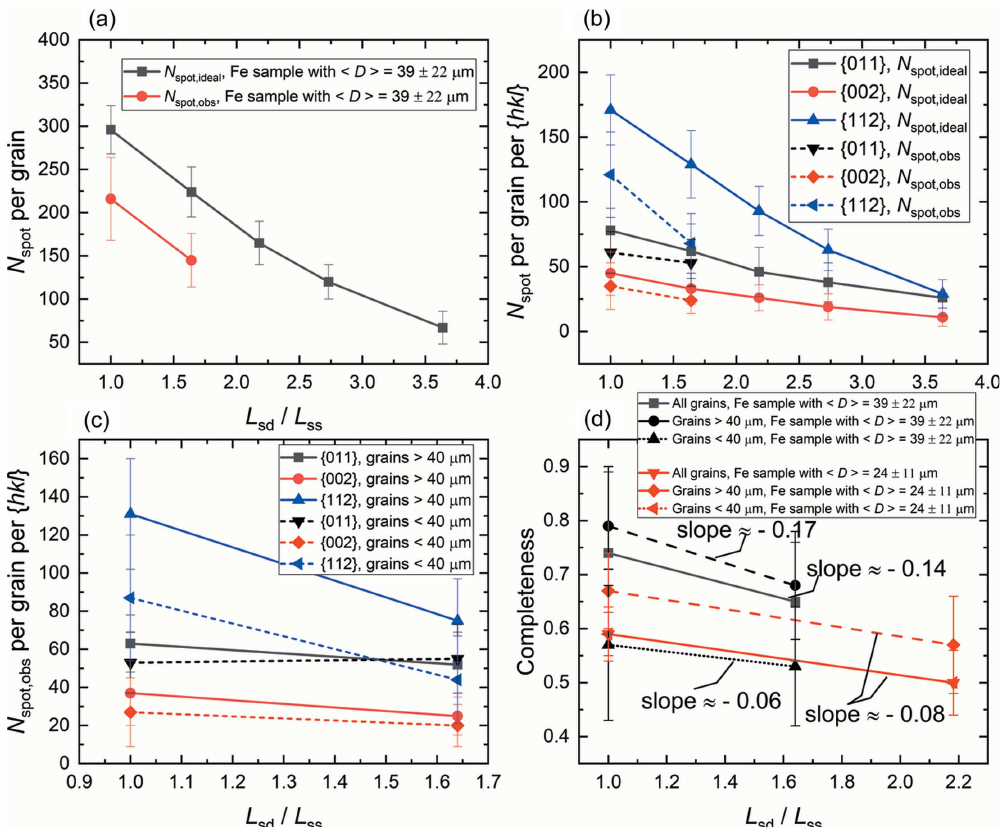
Figure 12 Average number of spots for the total of 181 projections and the completeness as a function of L sd / L ss . ( a ) N spot, ideal and N spot, obs per grain, ( b ) N spot, ideal and N spot, obs per grain for different { hkl }, and ( c ) N spot, obs per grain for different { hkl } for grains larger or smaller than 40 m m for the iron sample with h D i = 39 (cid:6) 22 m m. ( d ) Average completeness for all the grains in the two iron samples (with h D i = 39 (cid:6) 22 m m and h D i = 24 (cid:6) 11 m m) subdivided into two categories: larger or smaller than 40 m m. All measurement conditions were kept constant; only L sd / L ss was changed for any of the two